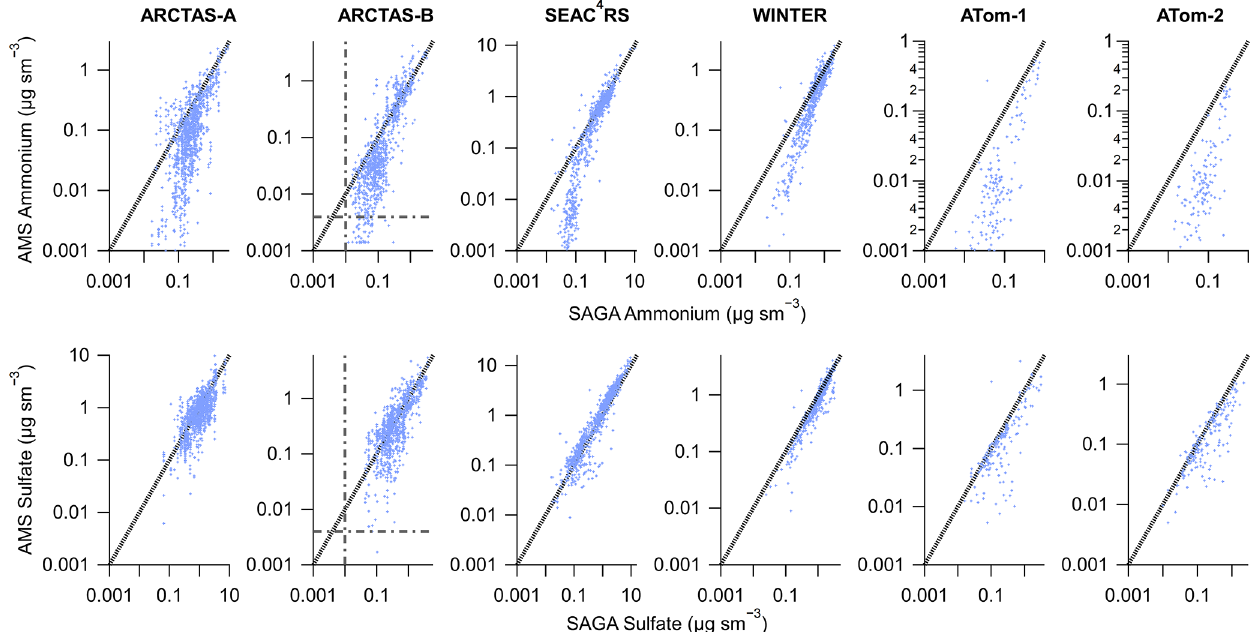
Figure 2. Scatter plot of AMS ( y axis) versus SAGA filter ( x axis) ammonium (top) and sulfate (bottom) mass concentration from six different aircraft campaigns. AMS data have been averaged over the SAGA filter collection times. The black line is the one-to-one line and the grey dash–dot lines are the estimated detection limits for AMS (DeCarlo et al., 2006; Guo et al., 2020) at the SAGA filter collection interval ( ∼ 5min) and the estimated detection limits for SAGA (Dibb et al., 1999). Data have been averaged to the sampling time of SAGA and have not been filtered for supermicron particles. For ATom-1 and ATom-2, data during ascent and descent have been removed (only level sampling at low altitude and high